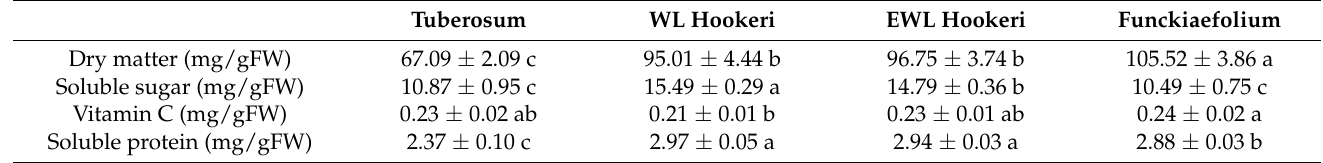
Figure 1. Pictures of Chinese chives and wild Chinese chives. The white vertical bar in the pictures indicate a scale of 5 cm. WL Hookeri, Wide-leaf A. hookeri ; EWL Hookeri, extra-wide-leaf A. hookeri. Table 1. Physiological comparison between Chinese chives and wild Chinese chives.